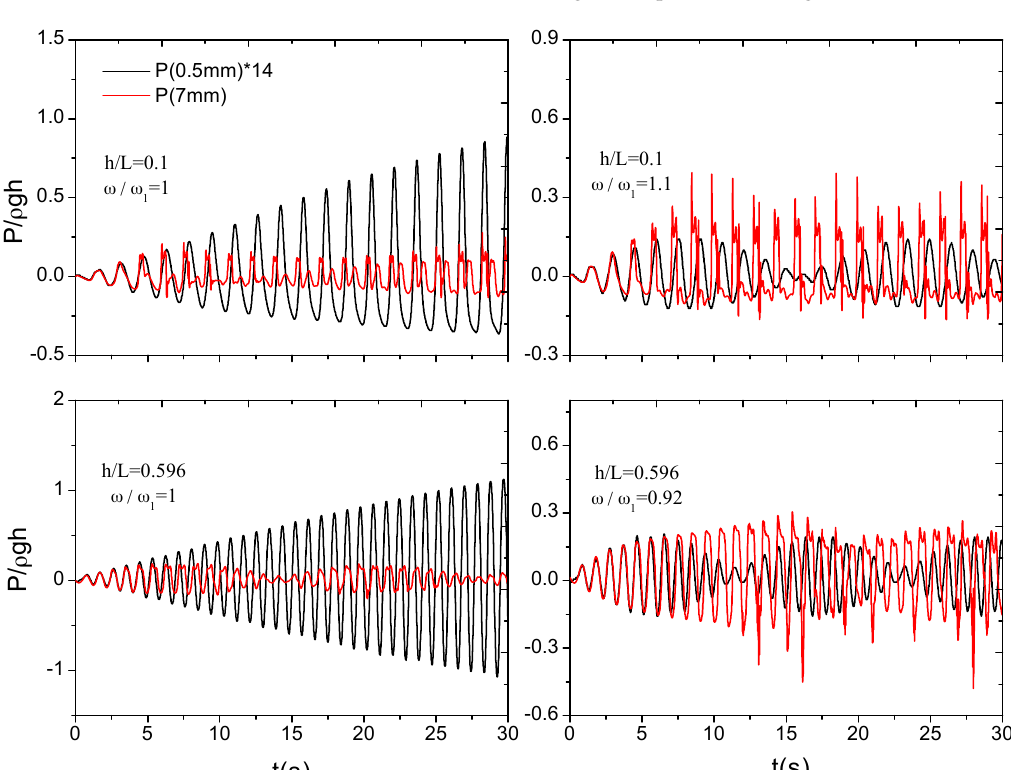
Figure 19. The comparison of pressure-time history curve with wave breaking or not. (red line: wave breaking; black line: no wave breaking).